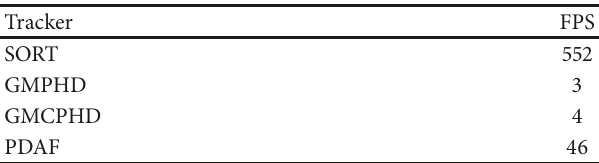
Table 8: The FPS for EventSeq-Vehicle1 using different tracking methods (SORT, GM-PHD, GM-CPHD, and